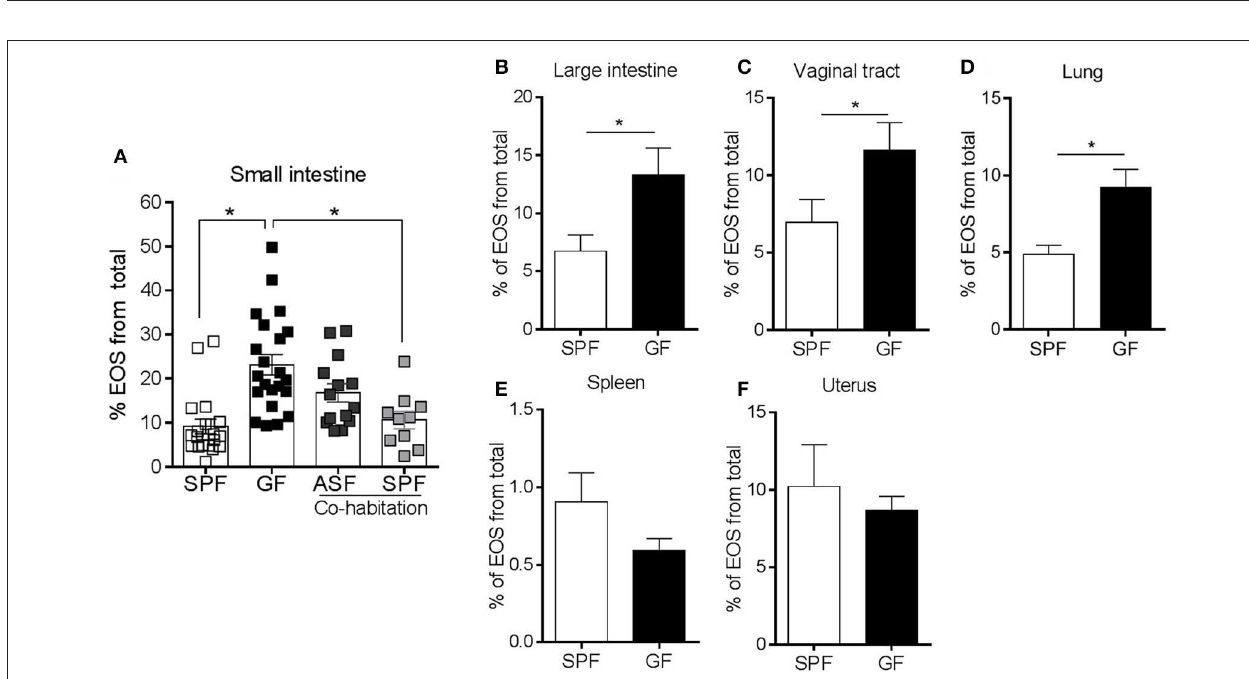
FIGURE 2 | Separate groups of GF mice were colonized by co-habitation with ASF or SPF mice and the presence of small intestinal eosinophils (EOS) was assessed (A) . Assessment of EOS frequency in the large intestine, vaginal tract, lung, spleen and uterus of SPF and GF mice by flow cytometry (B–F) . Pooled data from 2 to 5 experiments ( n = 8–22) represented as mean ± SEM, * P <